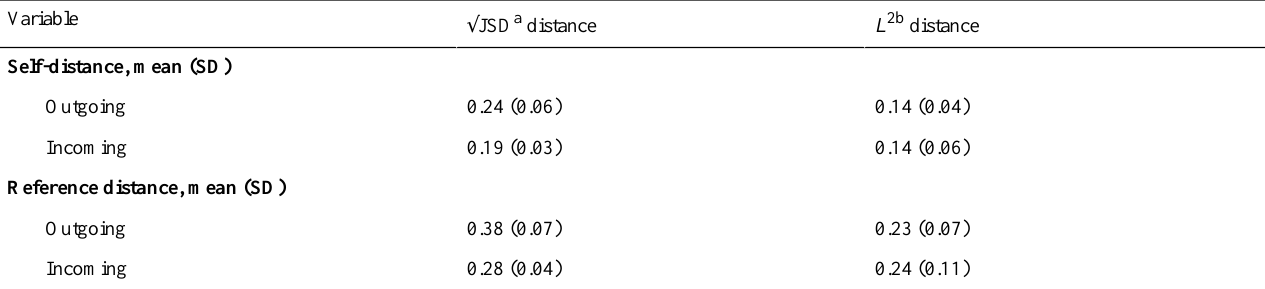
Table 2. Summary of averaged square root of Jensen-Shannon divergence and L2 metrics for the overall population for both reference distances and